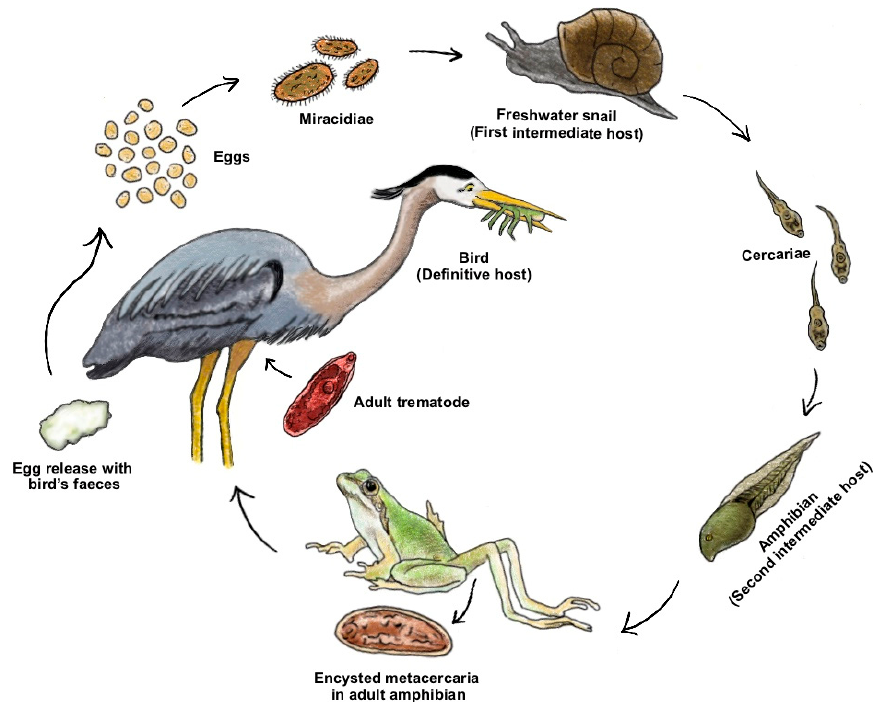
Figure 3. The life cycle of the trematode Ribeiroia ondatrae . Depicted hosts are as follows: the eggs of the worms are released to the water through the bird’s faeces and then hatch in a free-living form (Miracidiae) that infects its first intermediate host, the planorbid snail ( Planorbella sp.). After a series of stages inside the aquatic mollusk, another swimming form (Cercariae) is shed and infects the second intermediate host (Ranid tadpoles). Cercariae form cysts that impair the normal limb development in adult amphibians, causing deformities. Adult frogs with malformed limbs are more vulnerable to predation by the final host, the great blue heron ( Ardea Herodias (Linnaeus, 1758)). Source: Irene Hernandez-Caballero, 2022.